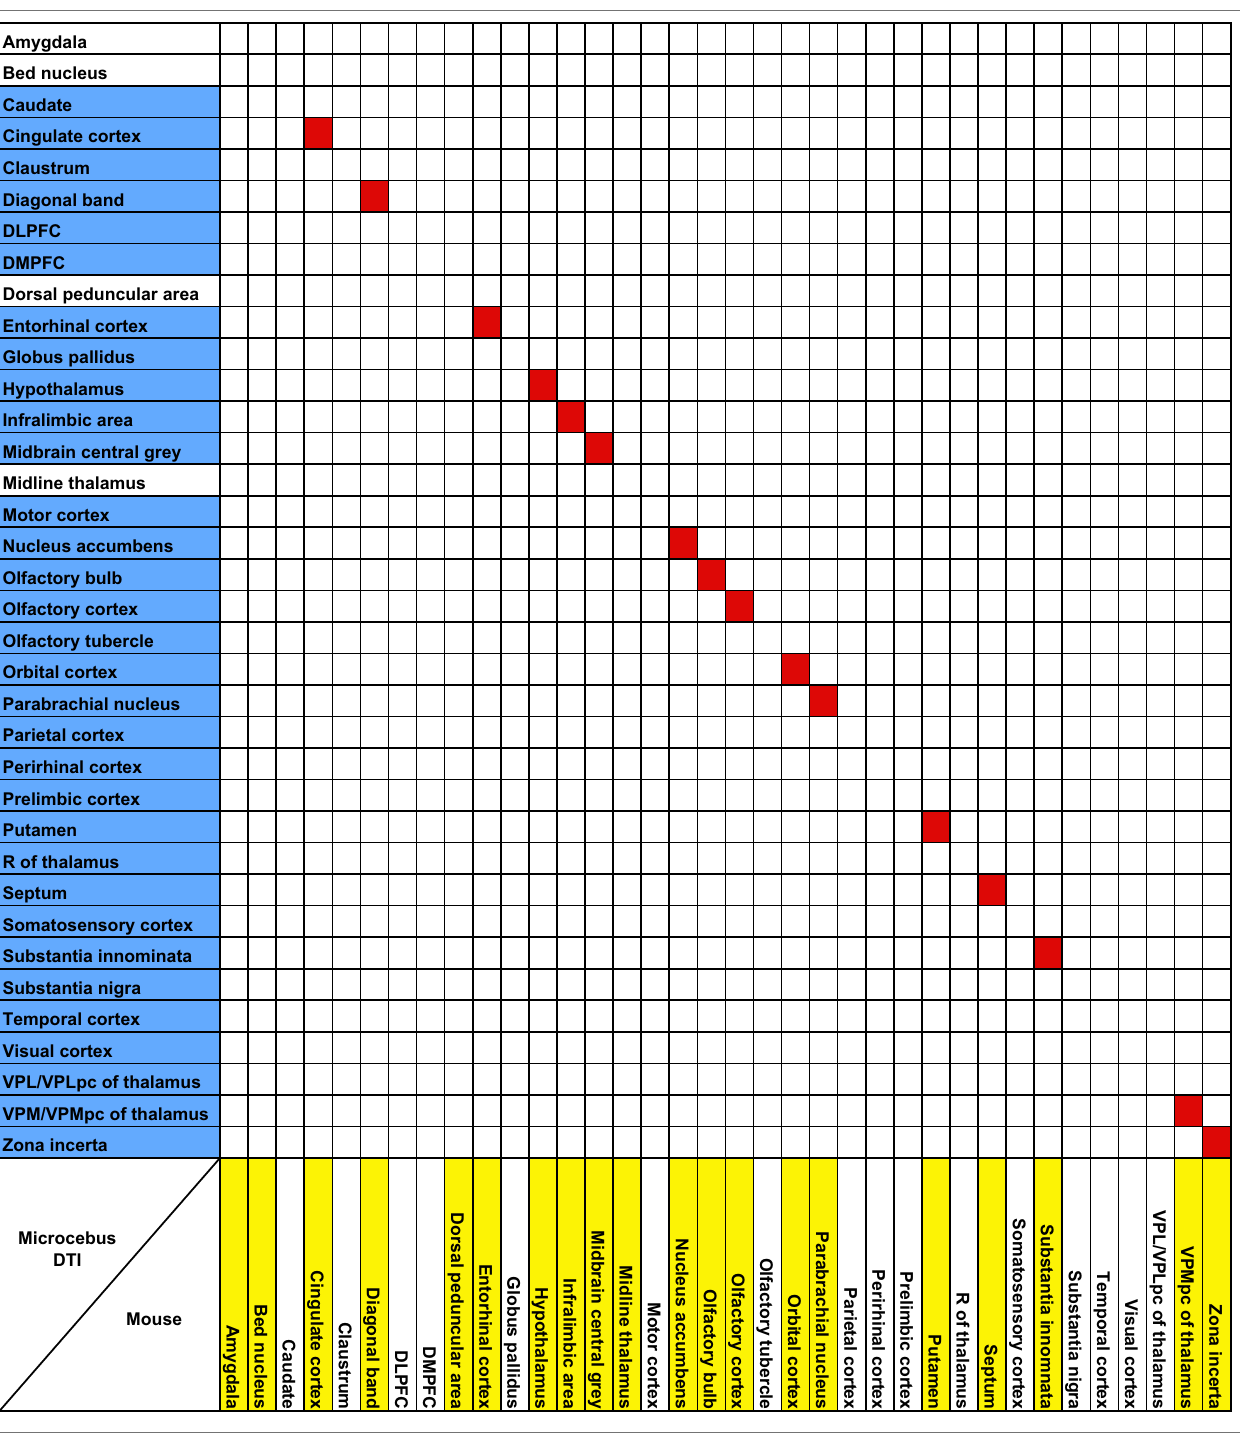
Table 4 | Comparison of insular connectivity in the mouse and the Microcebus . Amygdala Bed